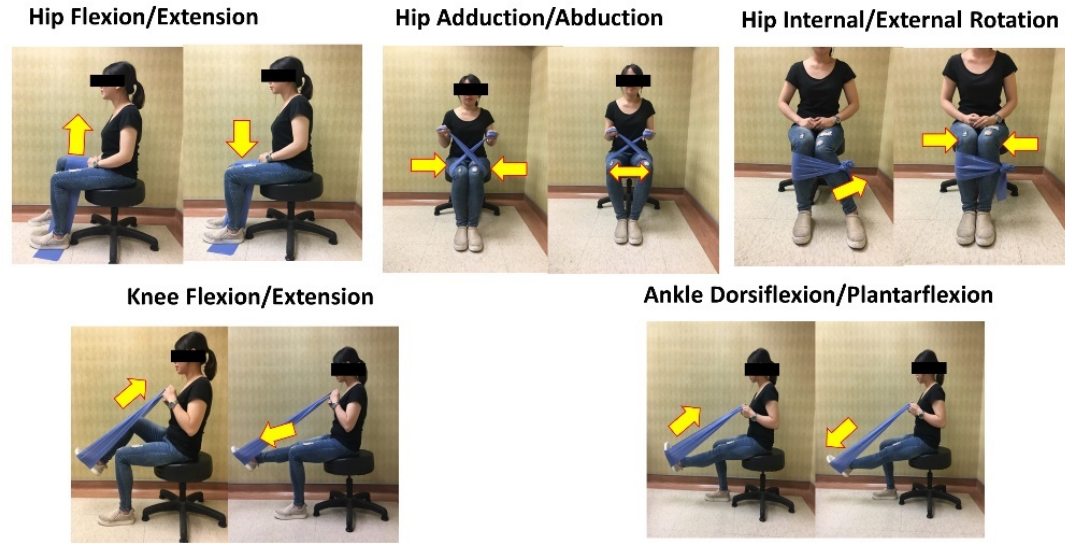
Figure 1. Elastic band resistance exercise intervention.